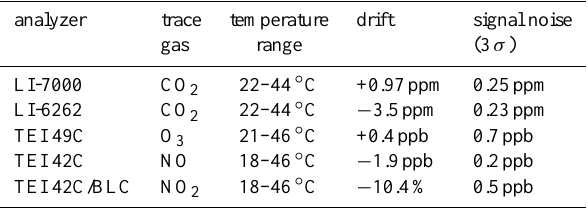
Table 5. Results of the temperature dependence tests of the analyz- ers used in this work. Stated temperatures are internal temperatures of the analyzers. The drift specifies the signal change over the whole temperature range. The signal noise is the maximum noise (3 σ ) de- tected with zero air during the